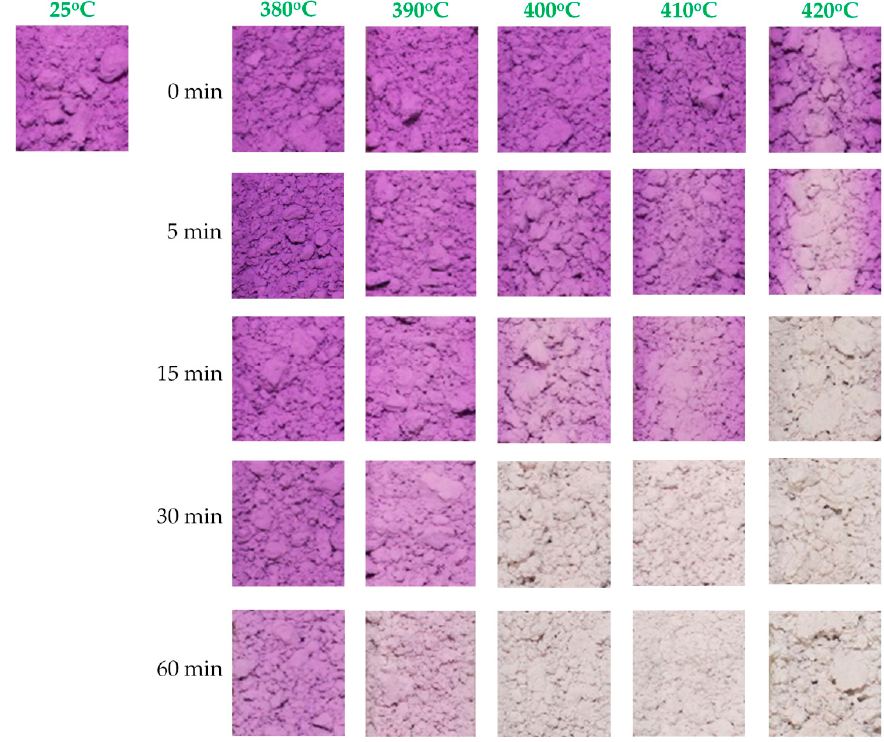
Figure 9. Color of synthesized manganese violet samples exposed at different temperatures for different periods after cooling. periods after